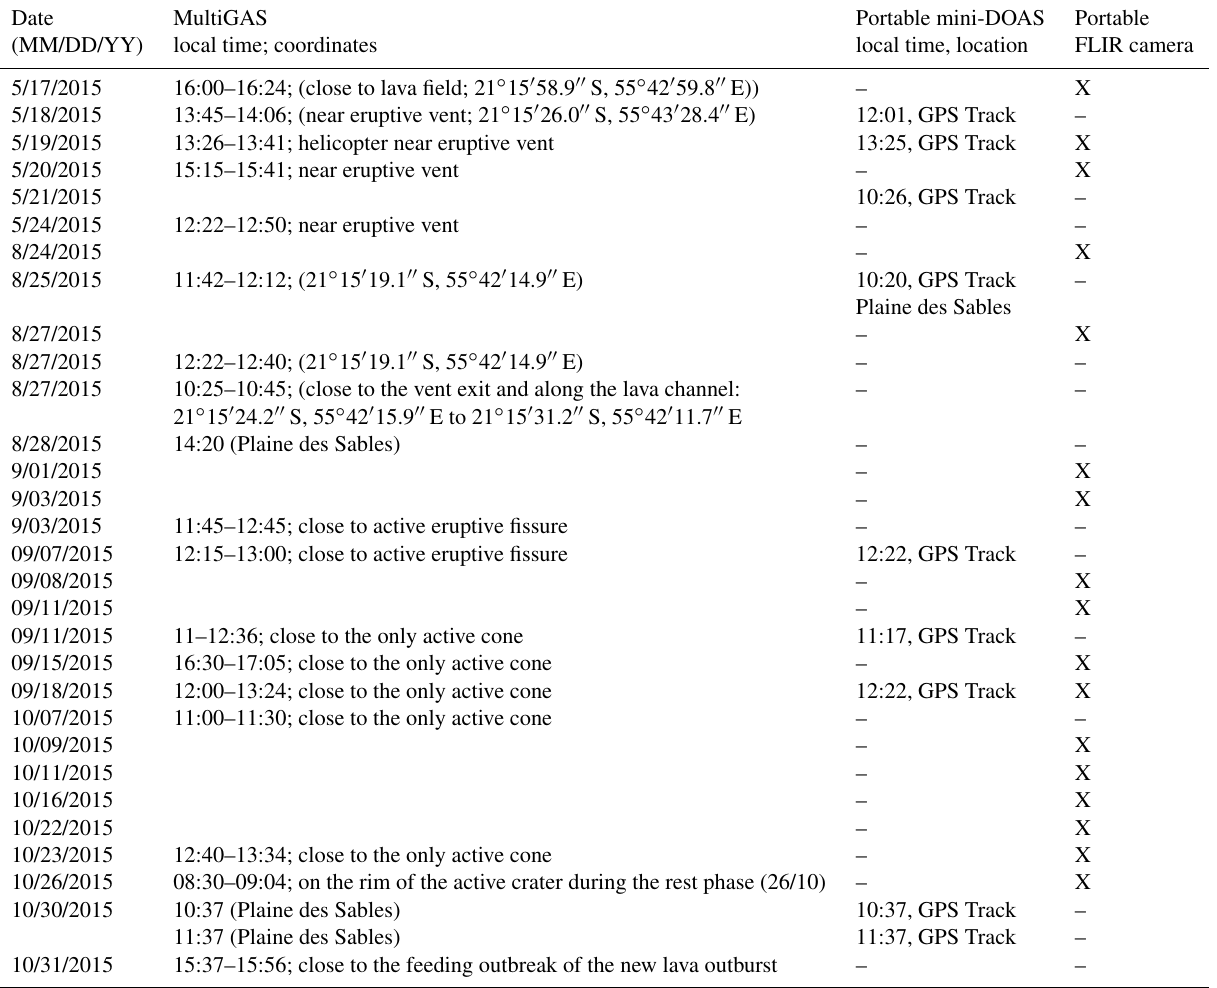
Table 1. Summary of in situ chemical measurements (MultiGAS, portable mini-DOAS and FLIR camera) made on field near the vent on May–October 2015. The symbol “X” indicates when measurements using FLIR camera have been